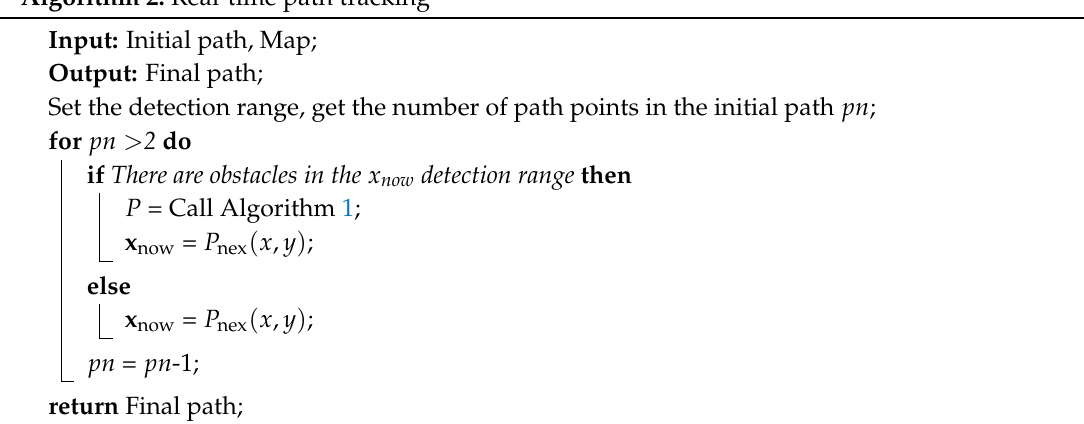
Algorithm 2: Real-time path